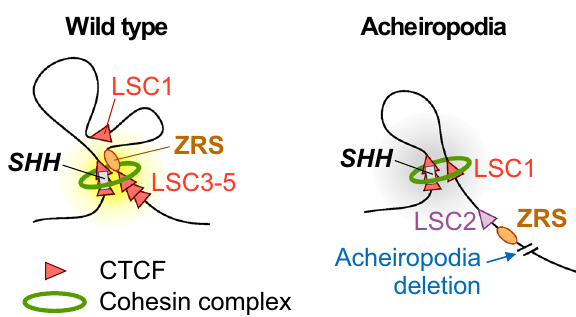
Fig. 7 Proposed model for the aberrant chromatin structure of the LMBR1 - SHH locus in the acheiropodia patient. Model of chromatin structure in the LMBR1 - SHH locus based on our ChIP-seq and 4C-seq data. CTCF sites are shown as red triangles and the cohesin complex is shown as a green ring. The ZRS is depicted as an